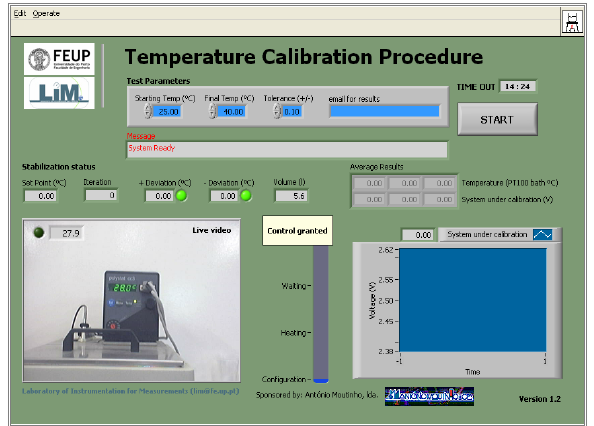
Figure 5. Surveys available at the experiment@portugal Web Figure 3. Temperatura calibration procedure remotely accessible: user interface.